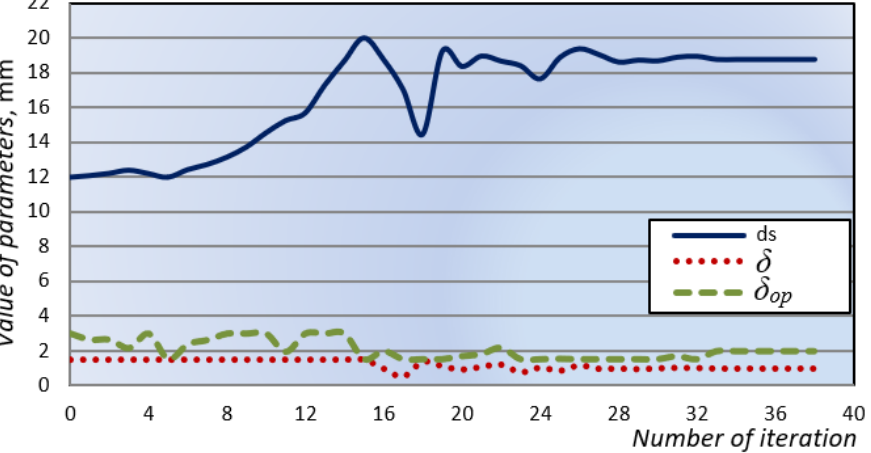
Figure 15. Changes of optimization parameters. Table 7. Comparison between initial and optimized design of external fixation